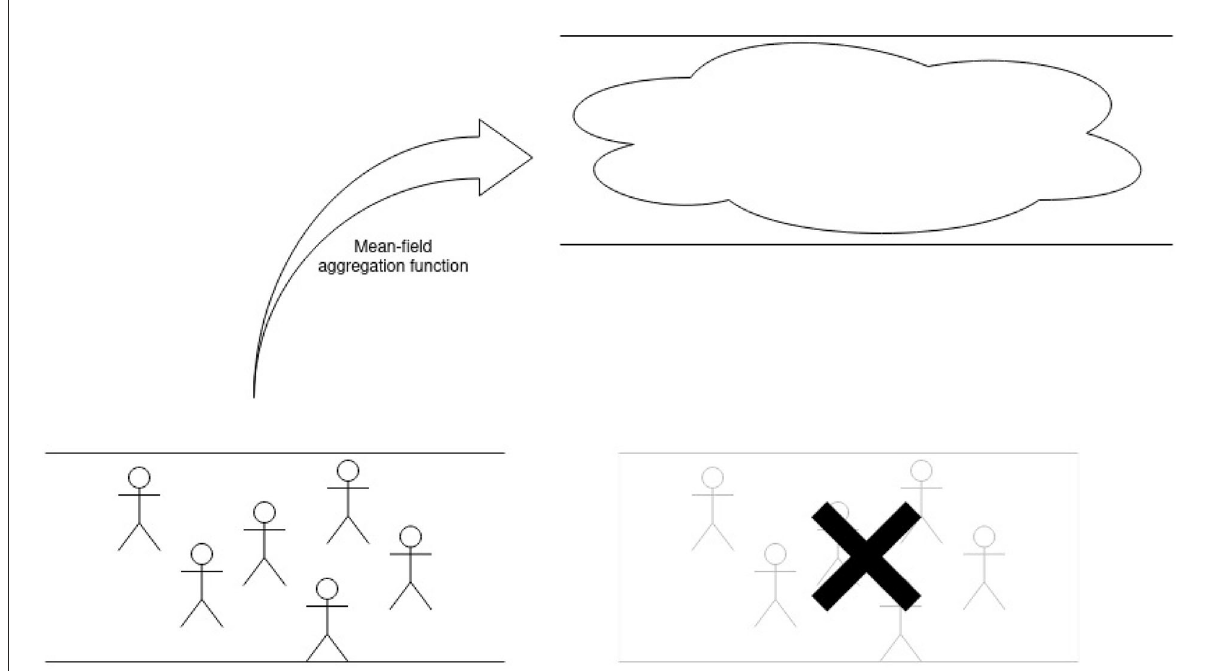
FIGURE3 Simplified representation of the example model in the Zoom pattern aggregating agents from the micro-level to an equation at the macro-level. This operation is destructive, then after the aggregation, the ABM is removed and the model runs only with the macro-level.